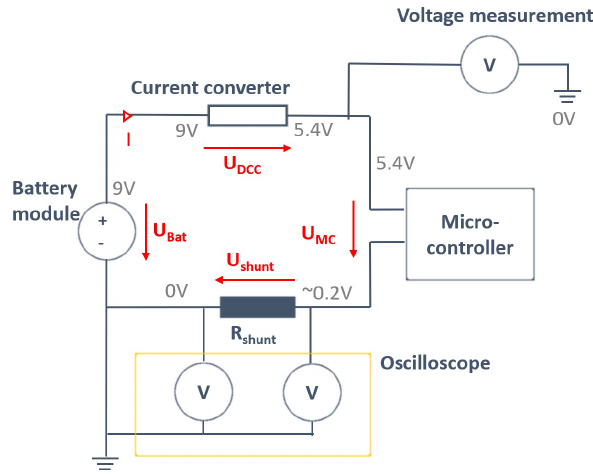
Figure 4. Electric circuit of the sensor node.